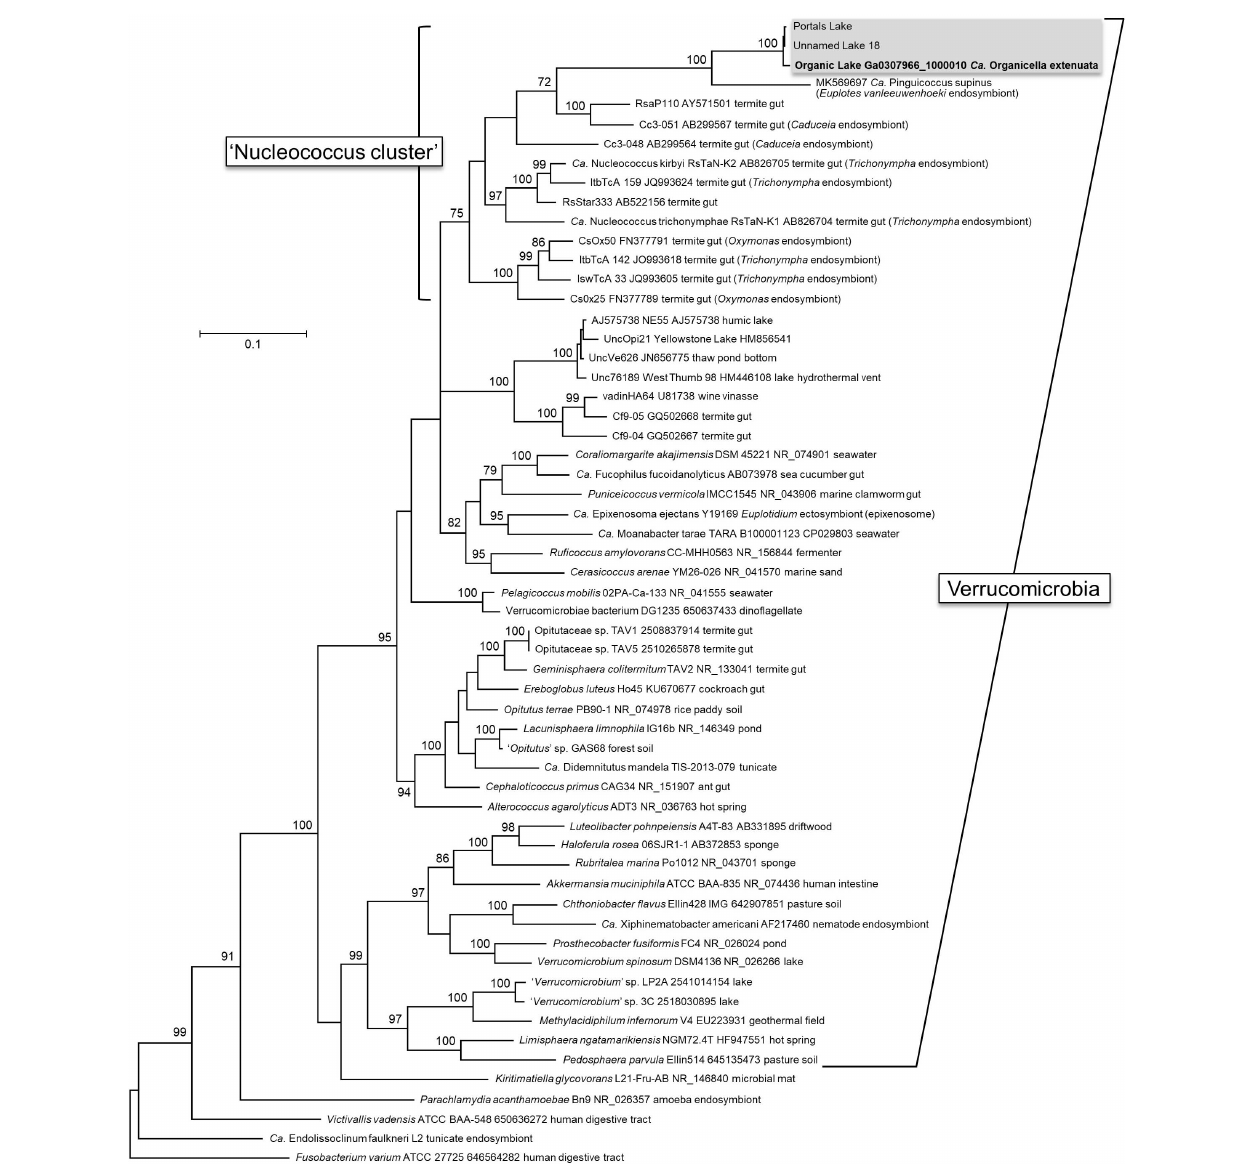
FIGURE 1 | Phylogeny of Candidatus Organicella extenuata. Phylogeny of Verrucomicrobia and related bacteria based on 16S rRNA sequences, showing Ca. Organicella extenuata nested inside the newly proposed “Nucleococcus cluster”; other than Ca. Organicella extenuata, this cluster comprises the cytoplasmic endosymbiont Ca. Pinguicoccus supinus from a freshwater ciliate and intranuclear endosymbionts of amitochondriate protists resident in the hindgut of termites. The maximum likelihood tree was constructed with 59 sequences, and positions with less than 80% site coverage were eliminated, resulting in 1,415 positions in the final dataset. Bootstrap values > 70 are shown next to individual nodes. Fusobacterium varium is the outgroup. Accessions are given as NCBI Nucleotide accessions or IMG Gene IDs: for Ca. Organicella extenuata, sequences were included for the original Organic Lake MAG (contig Ga0307966_1000010, bases 107297..108828), Unnamed Lake 18 (contig Ga0400283_000007, bases 52431..53966), and “Portals” Lake (contig Ga0400669_009478, bases 1..1071 and contig Ga0400669_039189, bases 1314..1821). Sequences identical to the 16S rRNA sequence from the original Organic Lake MAG were represented in metagenome data from 19 other Organic Lake metagenomes and also in Unnamed Lake 13 ( Supplementary Table 4 ). Note that nine-digit accessions are IMG Gene IDs, and all others are NCBI Nucleotide